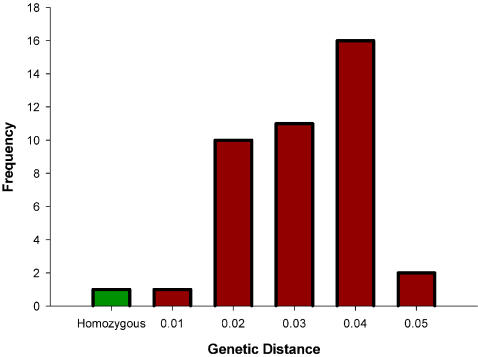
Frequency of genetic distances averaged over HLA-A and HLA-B.Homozygotes are indicated in green and heterozygotes in red.